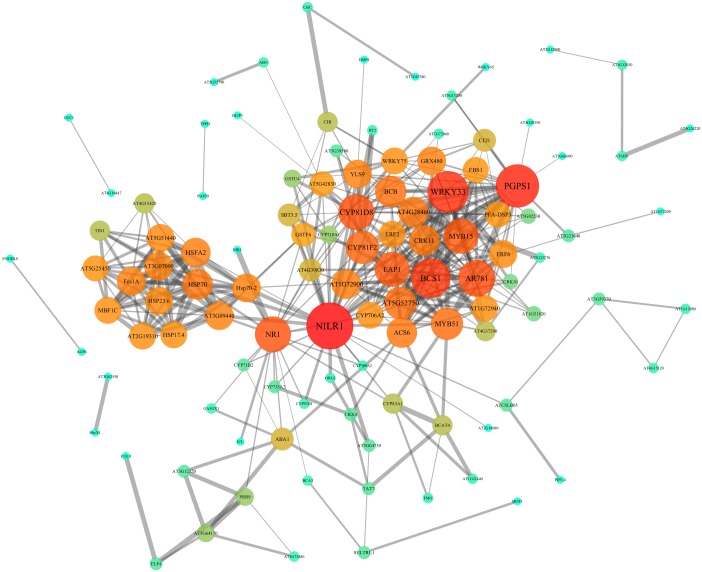
PPI network of identified DEGs constructed by the STRING database.Circles represent genes, lines represent the interaction of proteins between genes, and the results within the circle represent the structure of proteins. Line thickness and circle color represents the degree of significance between the proteins.